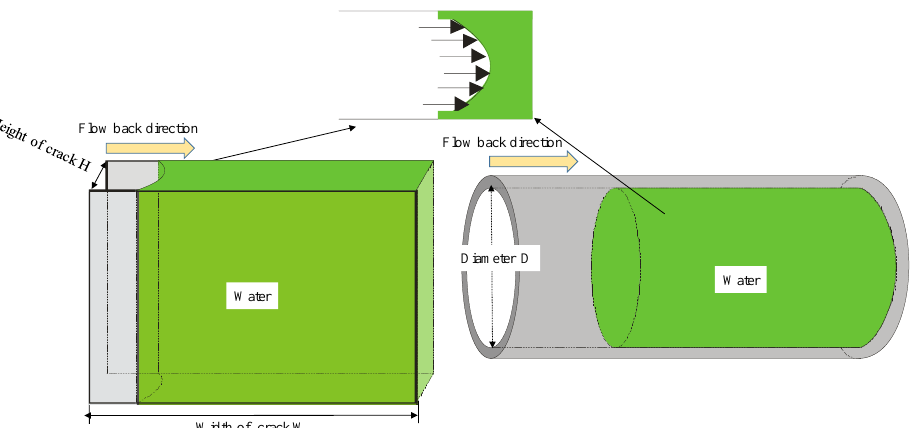
Figure 11. Schematic of flowback of water phase in slit pores and cylindrical pores (green is water phase).